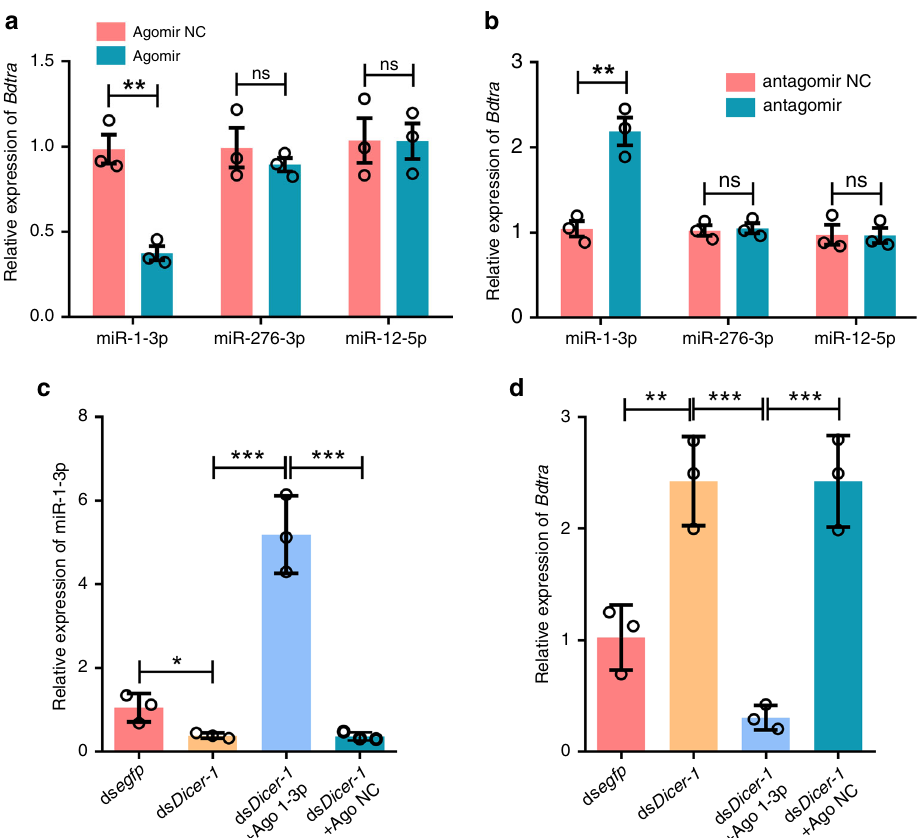
Fig. 3 miR-1-3p targets the Bdtra transcript in vivo. a Levels of Bdtra in 10 h embryos injected with the miR-1-3p, miR-12-5p or miR-276a-3p agomir, ( b ) levels of Bdtra in 10 h embryos injected with the miR-1-3p, miR-12-5p or miR-276a-3p antagomir, ( c ) levels of miR-1-3p in 10 h embryos injected with ds BdDicer-1 and the miR-1-3p agomir, and ( d ) levels of Bdtra in 10 h embryos injected with ds BdDicer-1 and the miR-1-3p agomir. Error bars indicate the SEM of three independent biological replicates and asterisks (* and ** and ***) indicate the statistically signi fi cant differences ( P < 0.05 and P < 0.01 and P < 0.001) between the treatment group and control group based on Student ’ s t-test. Ns indicates no statistically signi fi cant difference between the treatment group and the control treated with both ds BdDicer-1 and agomir-1-3p, the levels of Bdtra decreased signi fi cantly by 87% at 10 h post-injection, whereas co-injection of ds BdDicer-1 /agomir negative control (NC) had a similar effect on Bdtra expression compared to the ds BdDicer-1 treatment alone (Fig. 3d). These results demonstrate that BdDicer-1 is required for miR-1-3p biogenesis and, hence, for the reduction of Bdtra mRNA levels induced by miR-1-3p.